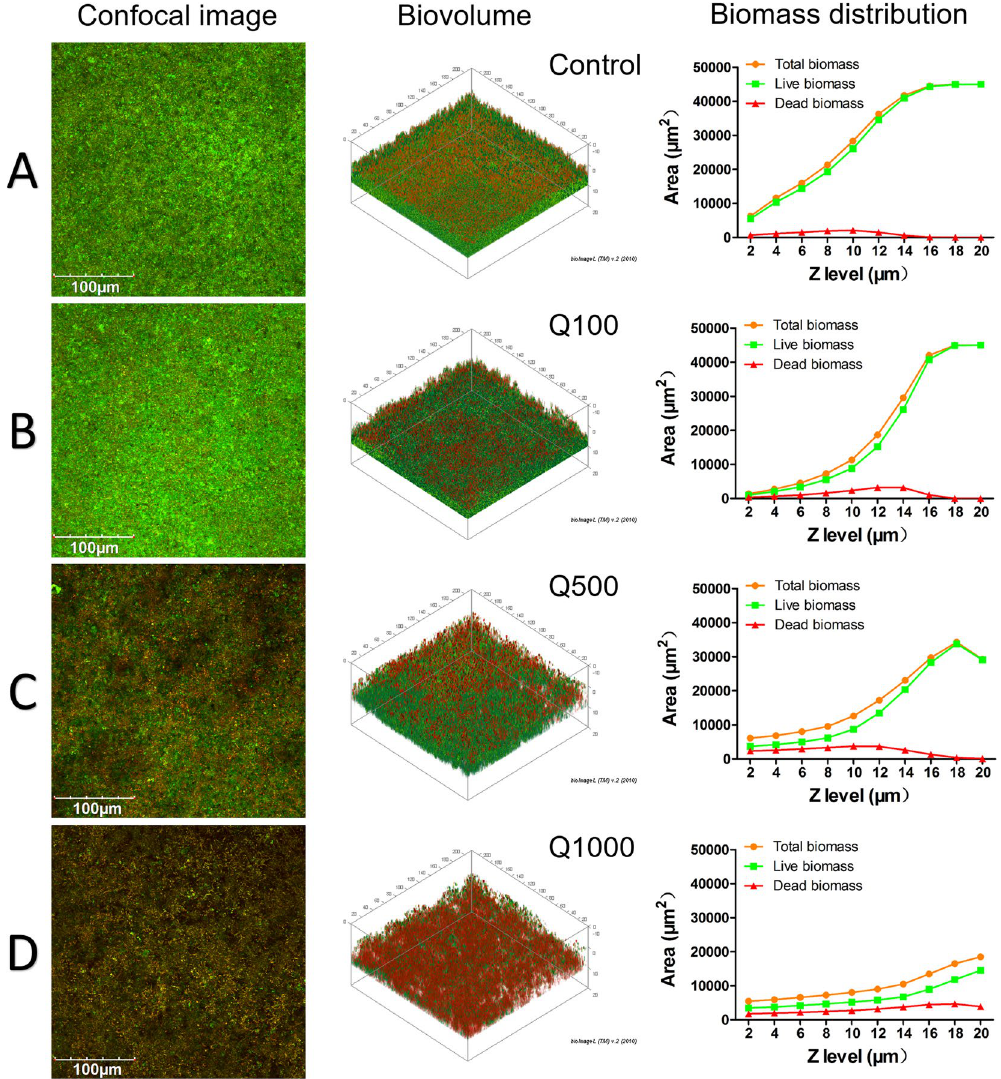
Figure 2. Confocal laser scanning microscopy evaluation of S. mutans biofilms grown on adhesives of 4 groups (live-green; dead-red). ( A ) Control group; Quercetin-doped adhesive groups at the concentration of ( B ) 100 ug/mL, ( C ) 500 ug/mL and ( D ) 1000 ug/mL. (Left) Top-down view; (Middle) 2D overlay projections; (Right) corresponding biomass distribution of total, live and dead bacteria at each layer along the Z stack (layer interval = 2 um, scanning depth = 20 um).